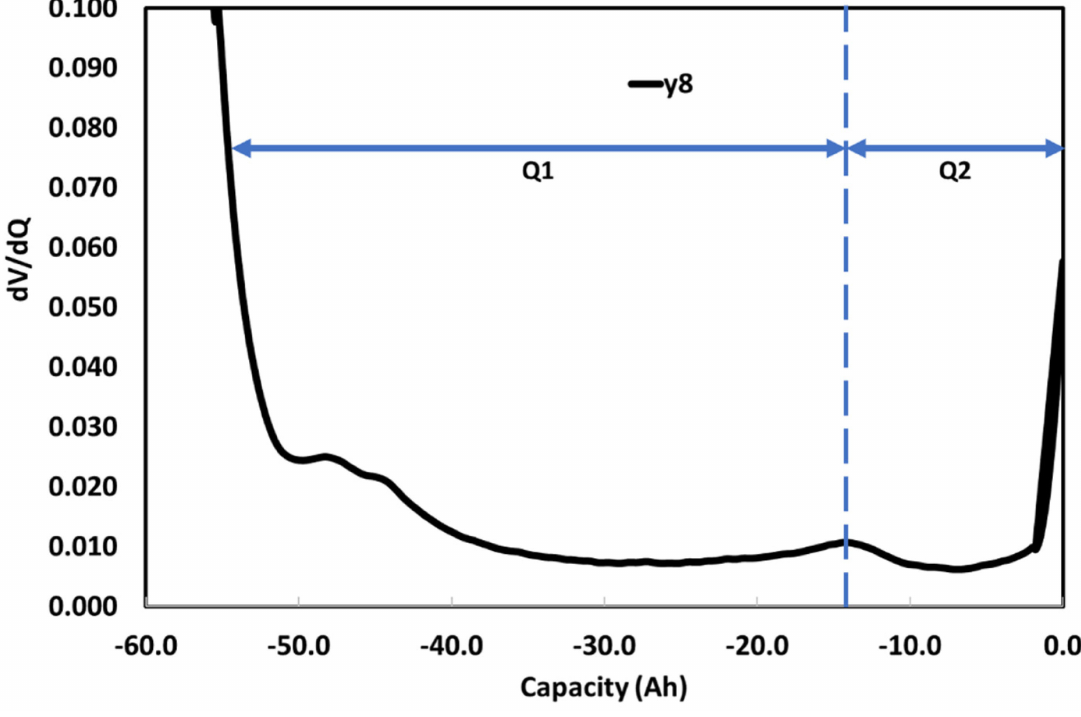
Figure 13. Identification of the Q1 and Q2 regions in DV spectra indicative of LAM and LLI,